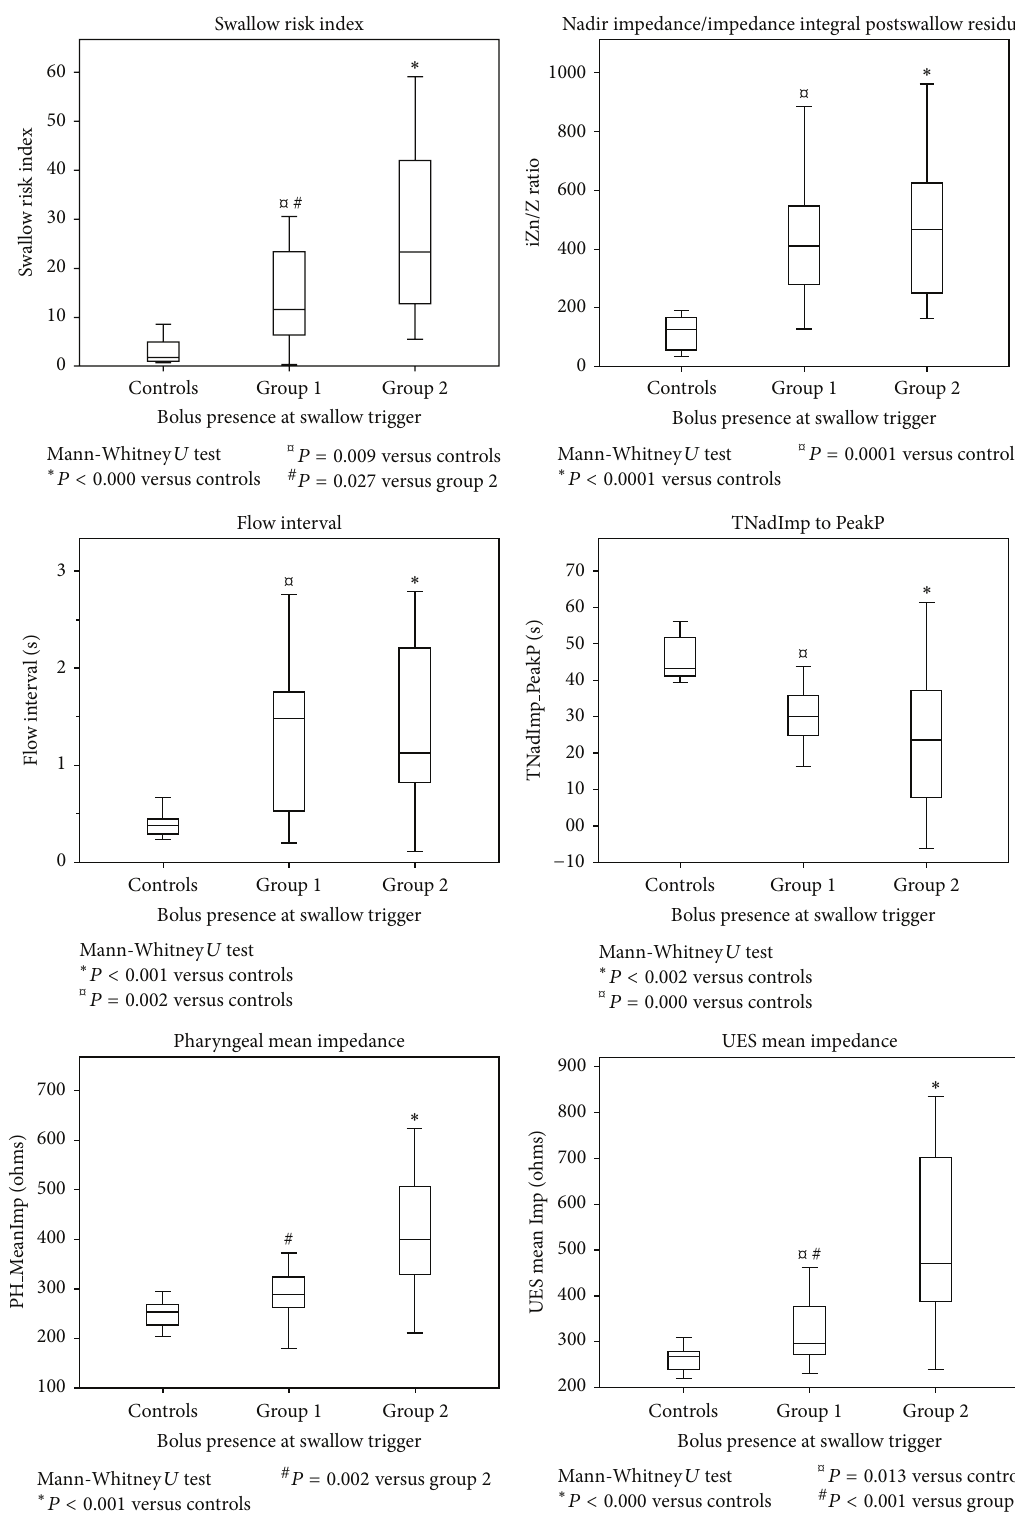
∗ P < 0.000 versus controls Figure 2: Pressure flow analysis metrics recorded in relation to bolus presence to the pyriform sinuses prior to swallow onset. Group 1: patients NEVER demonstrating bolus to the pyriform sinuses at the time of swallow onset. Group 2: patients demonstrating bolus to the pyriform sinuses AT LEAST ONCE at the time of swallow onset. Controls: in all cases bolus was in the mouth or at base of tongue at time of swallow onset. Data are median (IQR) for liquid swallows. 𝑃 values are from Mann-Whitney 𝑈 tests with Bonferroni correction for multiple comparisons, 𝑃 < 0.017